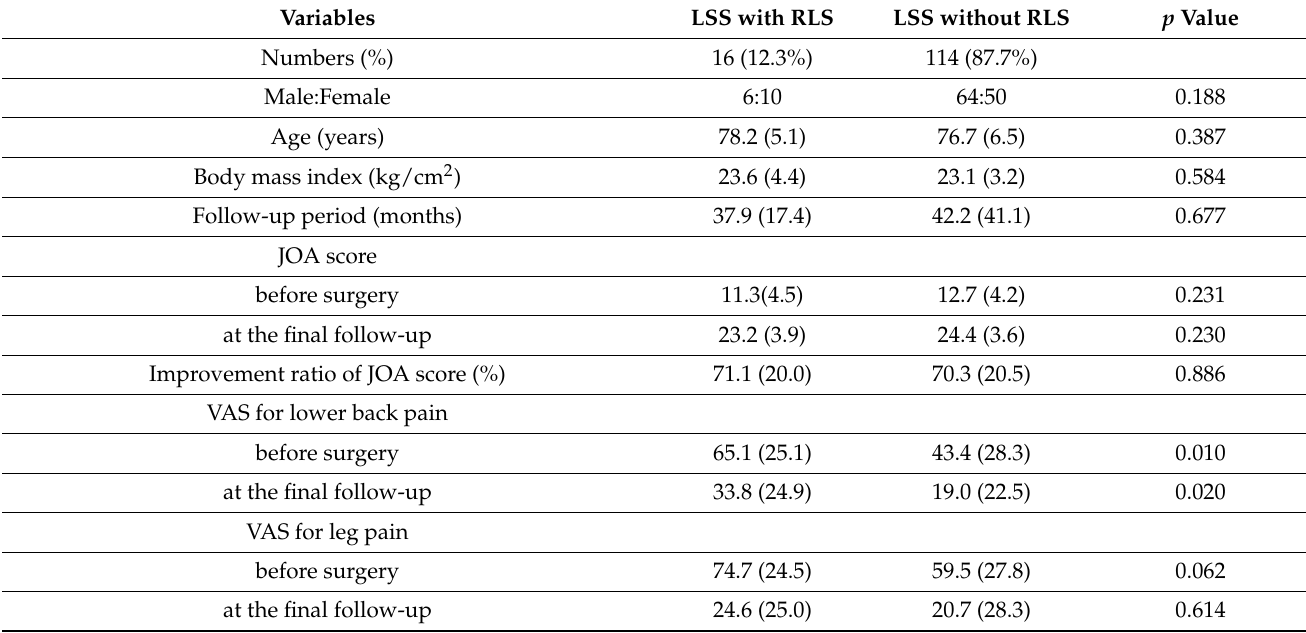
Table 2. Comparison of baseline characteristics and clinical outcomes of patients ( n = 130) who performed lumbar decompression surgery between those with and those without restless legs syndrome. RLS —restless legs syndrome, IRLSSG —the international restless legs syndrome study group, HADS —the hospital anxiety and depression scale, HADS- A —HADS anxiety, HADS-D —HADS